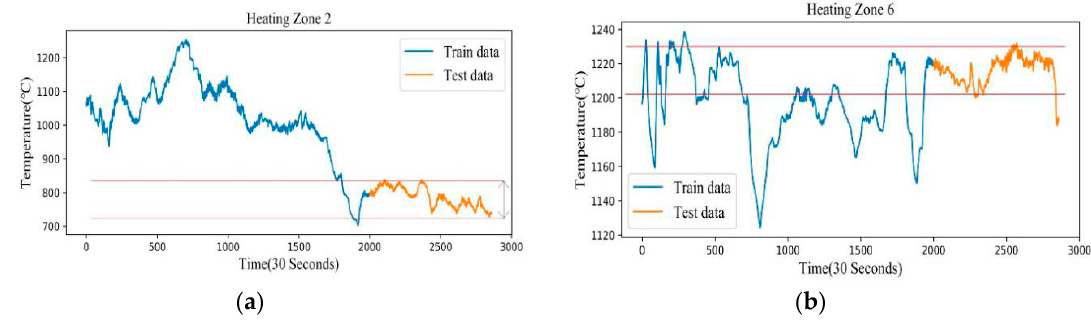
Figure 5. We choose two heating zones to show that the neural network has no extrapolation ( a ) Table 2. ( b ) Training and test set distribution of target variable in heating zone 6.